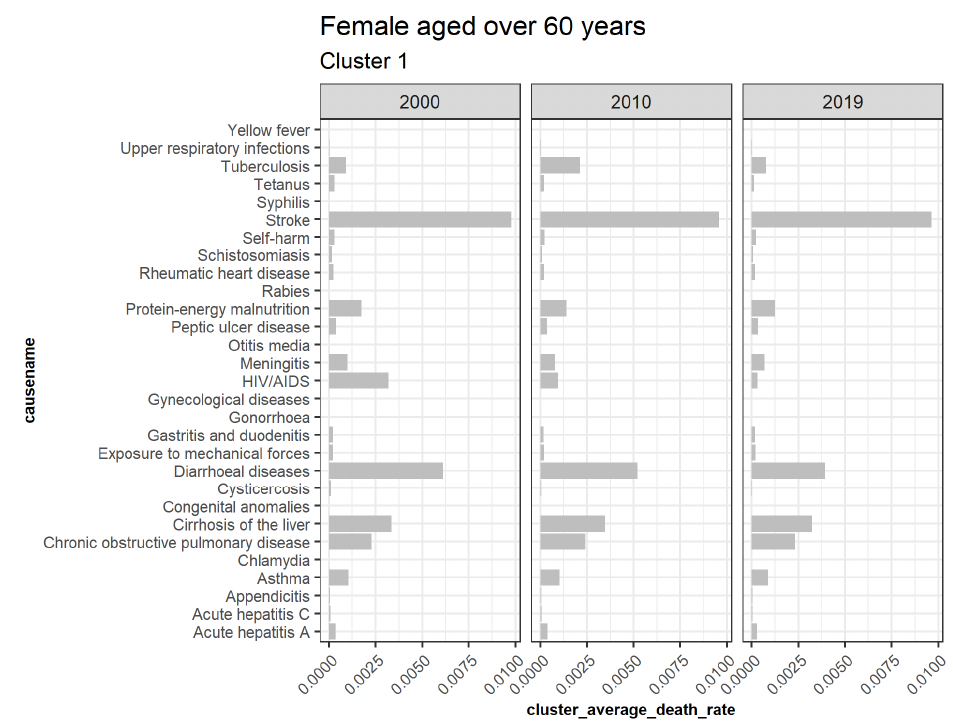
Figure 12. Declining trend causes among older females in cluster 1 for 2000, 2010, and 2019.